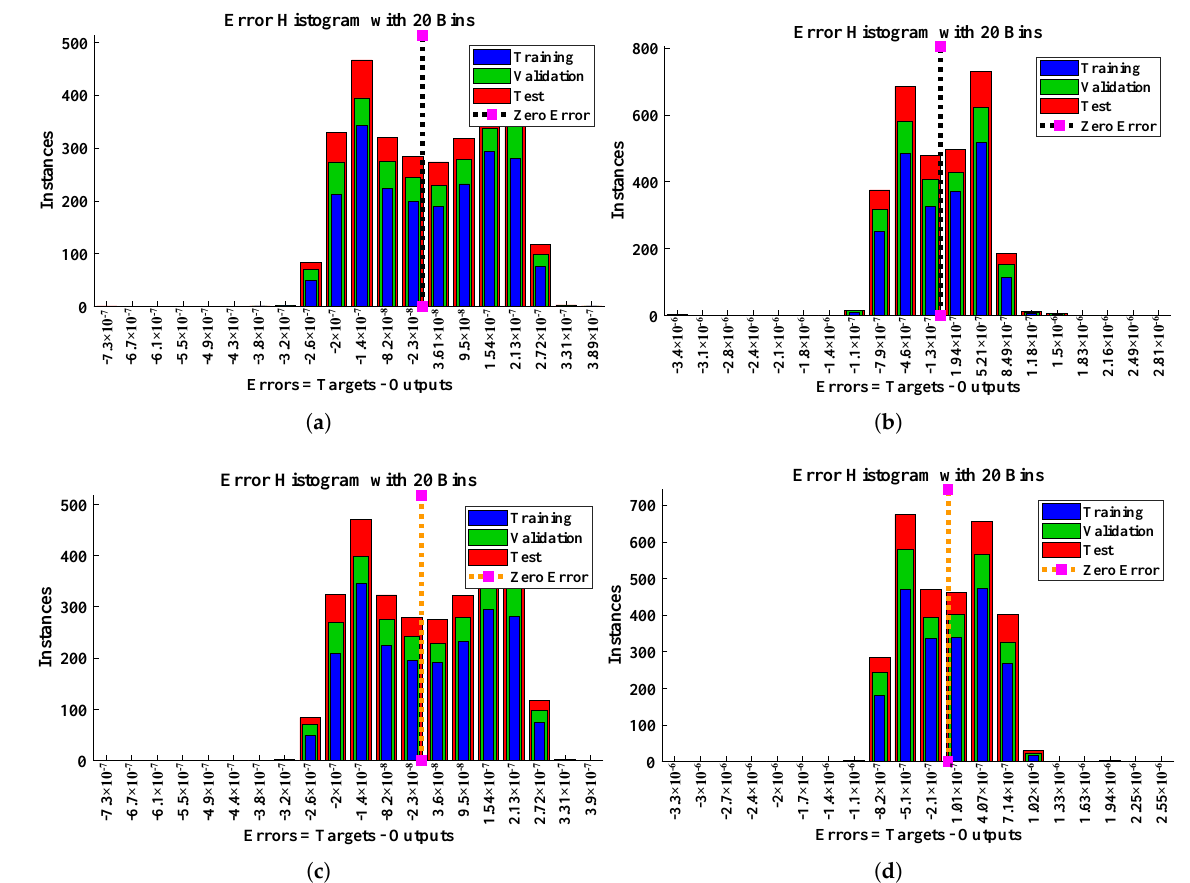
Figure 6. Estimated errors from histogram for validation, testing, and training data along with minimum or zero error for the velocity and acceleration of the micro-polar fluid with different sets of boundary conditions: ( a , b ) isothermal and ( c , d )